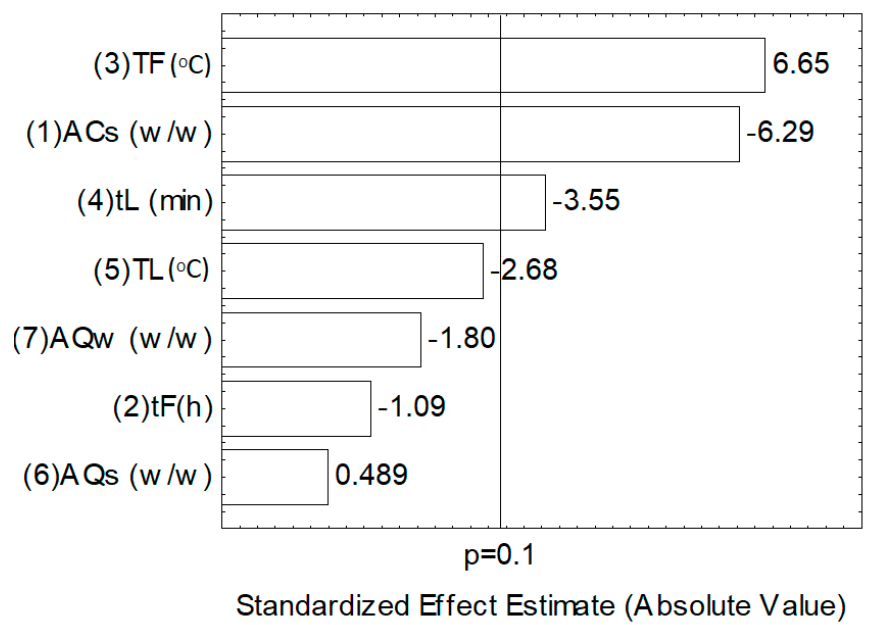
Figure 9. Effect of the process variables on the ratio of REE extraction to iron extraction (%RE/%Fe)